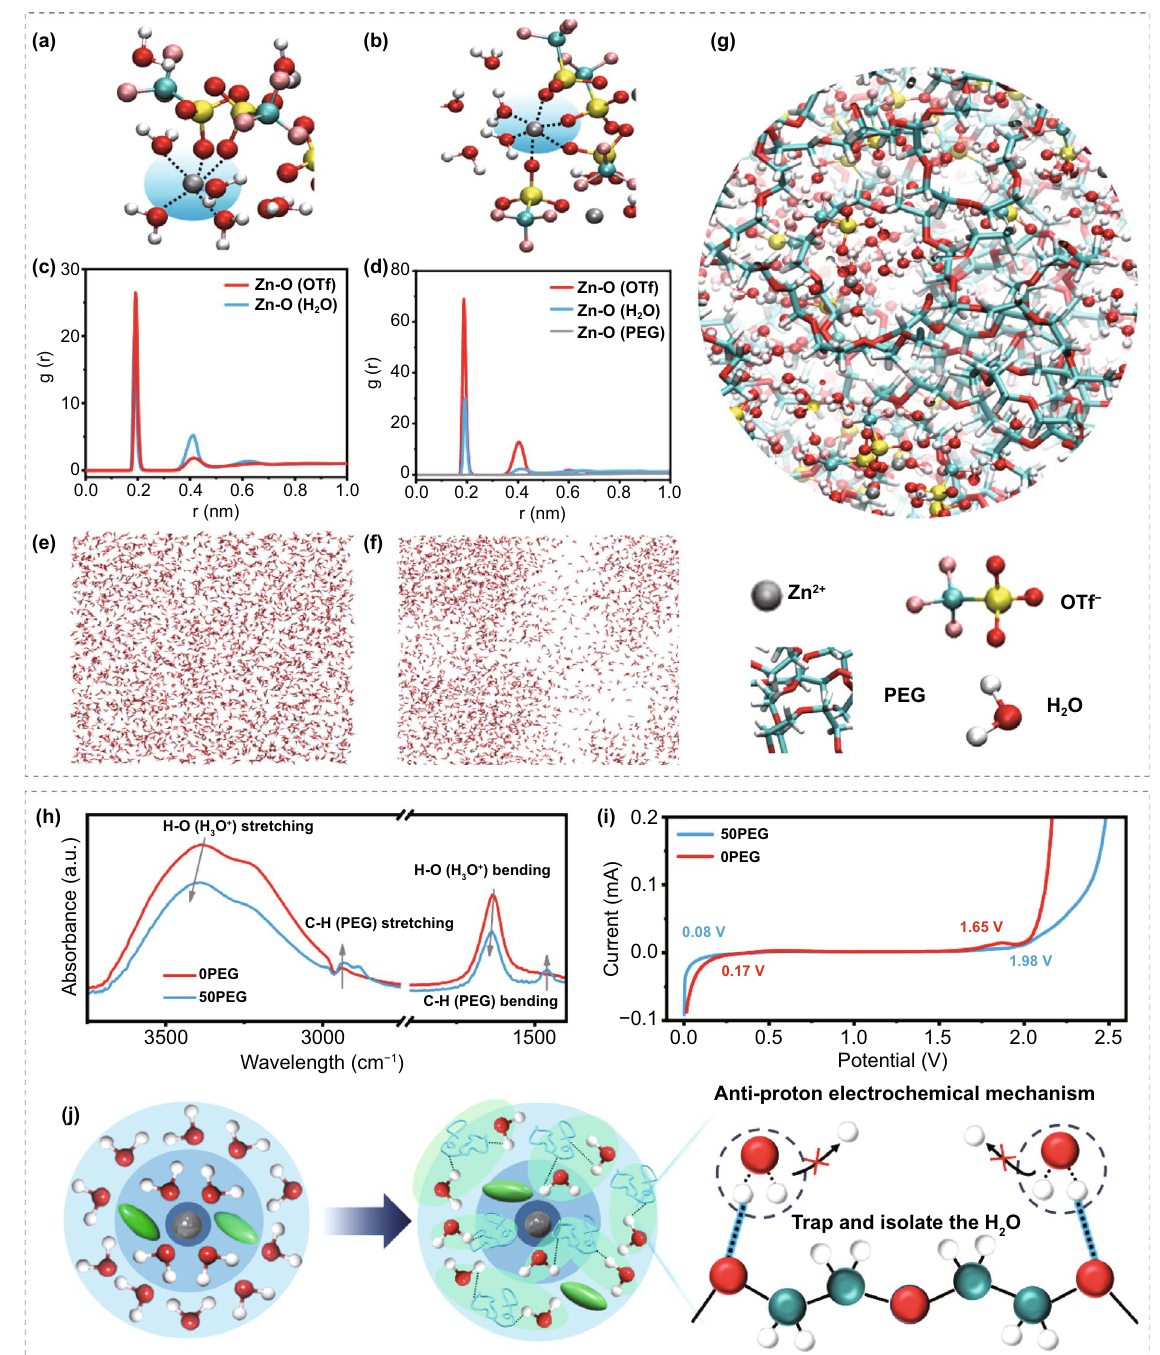
Fig. 1 Typical Zn 2+ solvation structure of a 0PEG and b 50PEG electrolyte. The radial distribution functions RDFs g(r) for Zn 2+ -O(H 2 O), Zn 2+ -O(OTf − ) and Zn 2+ -O(PEG) of the c 0PEG and d 50PEG electrolyte. Simulation snapshots of only water molecules of the e 0PEG and f 50PEG electrolyte. g The snapshot of water molecules absorbed by the PEG-rich regions in the 50 PEG electrolyte. h Normalized FTIR spectra of the 0PEG and 50PEG electrolyte. i LSV curves of the 0PEG and 50PEG electrolyte at a scan rate of 0.1 mV s −1 . j The illustration of anti- proton electrochemical mechanism regulated by PEG additive